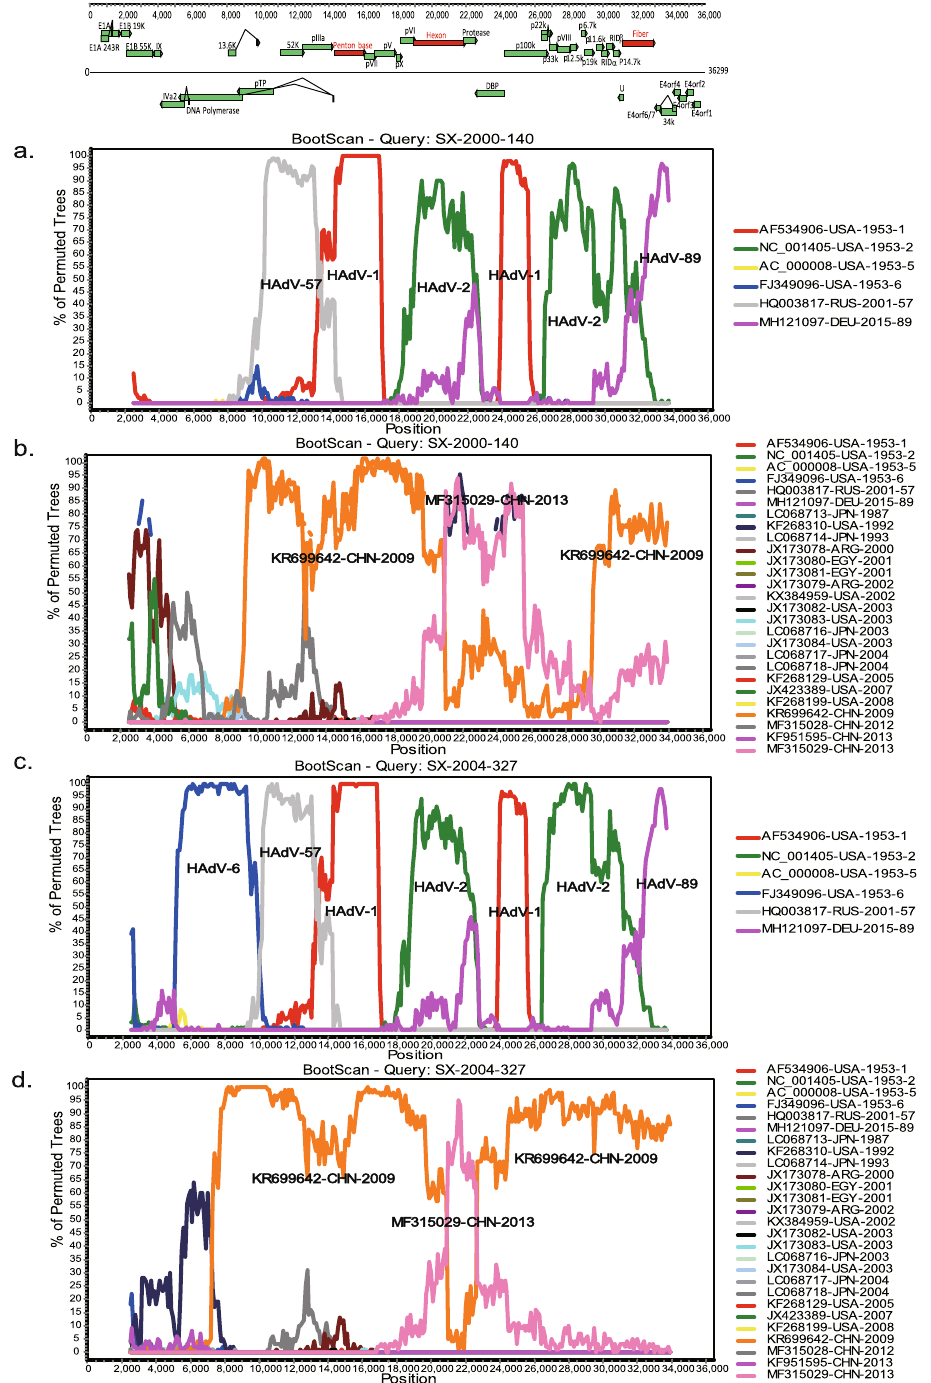
Figure 3. Genetic recombinant analysis of WGS of the two Shanxi strains. The sequences of strains SX-2000- 140 ( a ) and SX-2004-327 ( c ) were used as the query sequences against the prototype stains of six HAdV-C types. The sequences of strains SX-2000-140 ( b ) and SX-2004-327 ( d ) were used as the query sequences against the sequences of the four Chinese HAdV-C strains and 23 foreign HAdV-C strains downloaded from the GenBank database. The image shows the organization of the HAdV-C genome. Parameters were set to the default settings as follows: window size of 5000 bp, step size of 100 bp, gap stripping, 100 replicates, kimura (2-parameter), and